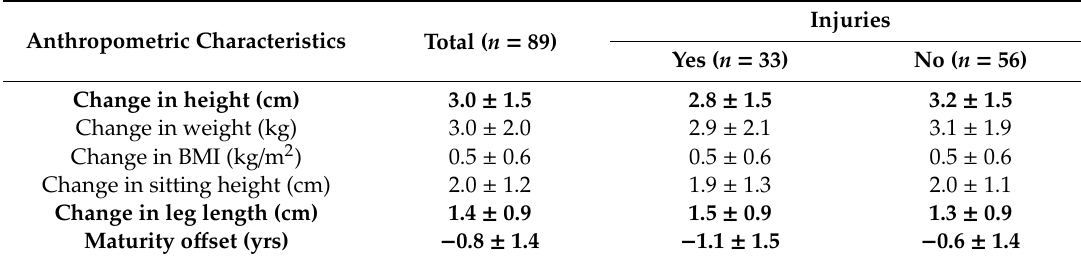
Table 3. Biological maturity status and changes in anthropometric characteristics for total sample and athletes with and without